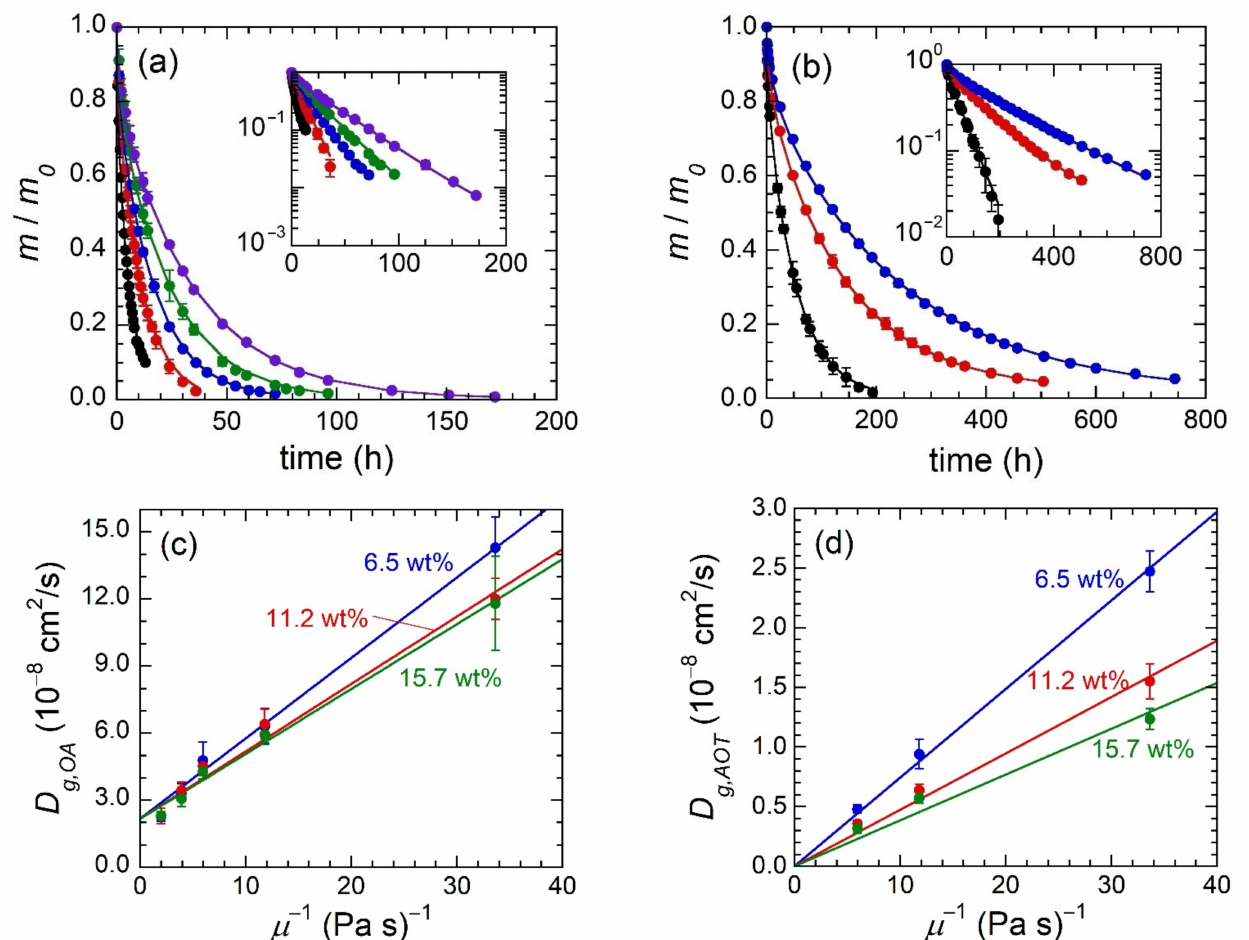
Figure 4. Time-resolved retained mass of OA ( a ) and AOT ( b ) for gels comprised of various MOs (black = squalane, red = HB 200, blue = HB 380, green = HB 550, purple = HB 1000) and 11.2 wt% SEBS. Insets show the same data plotted on a semi-log scale. Diffusivity values for OA ( c ) and AOT ( d ) through gels composed of varying SEBS concentration (labeled) and MO identity. Lines in ( a , b ) are fits using Equation (5), whereas lines in ( c , d ) are linear fits to the data including a fixed y-intercept value of 0 cm 2 /s in ( d